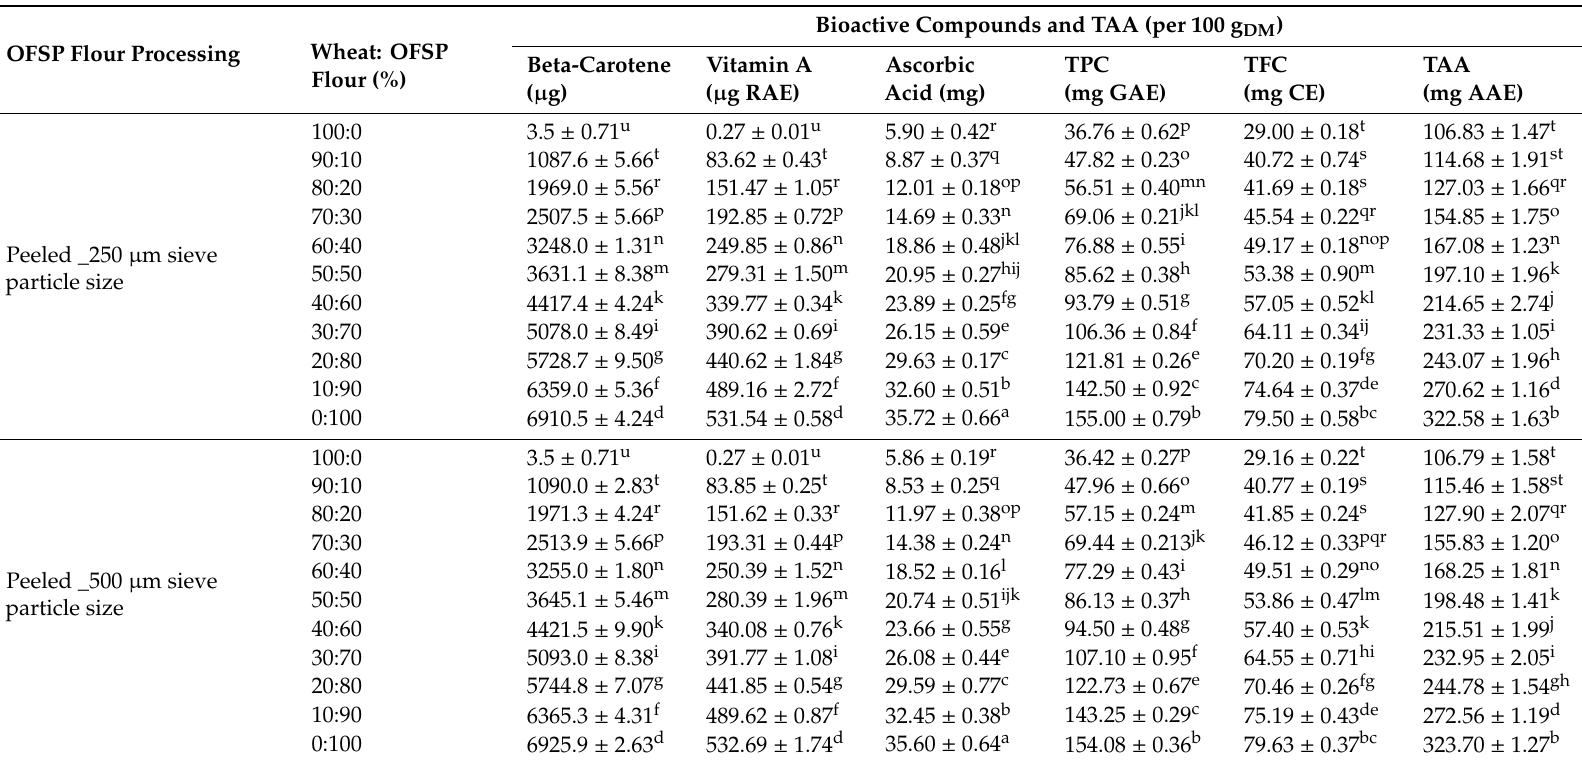
Table 3. E ff ect of sieve particle size and blend proportion on the bioactive compounds of peeled and unpeeled OFSP composite flours.